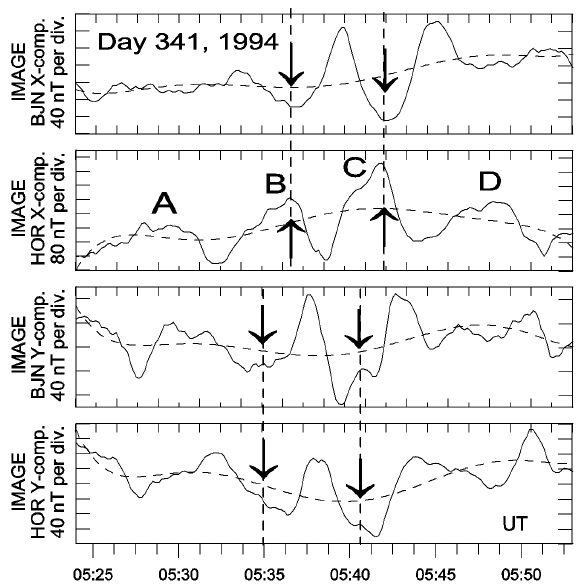
Fig. 2. Same format as in Fig. 1, for the event of day 341, 1994. The X-component wave at HOR changed its phase by 180 ◦ as compared to that at BJN. The Y-component traces show pulsations